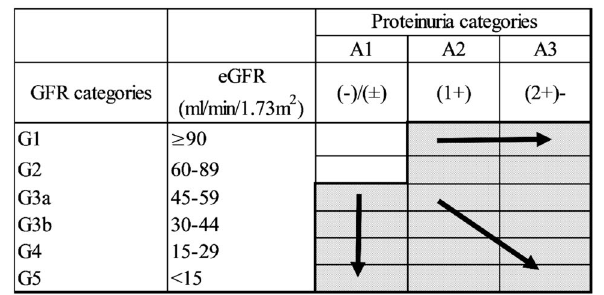
Figure 1. Definition of outcomes. The colored area was eligible for study (those with CKD at baseline). Progression of CKD was defined as exacerbation in the eGFR category or urinary protein category from baseline categories according to the Kidney Disease: Improving Global Outcome (KDIGO) CKD